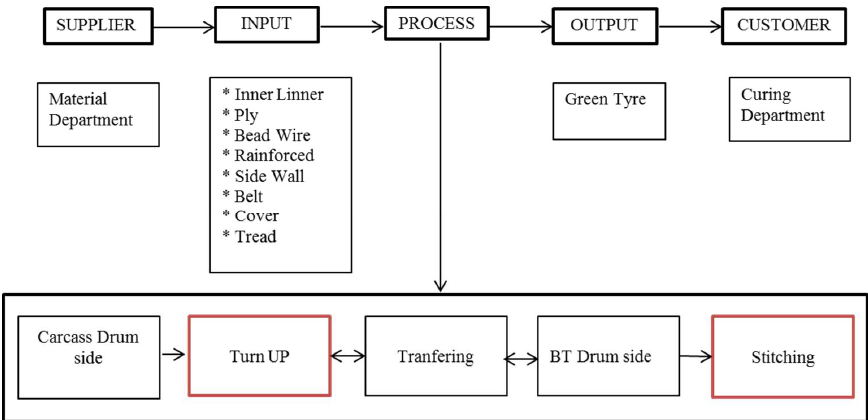
Fig. 2. SIPOC diagram of building